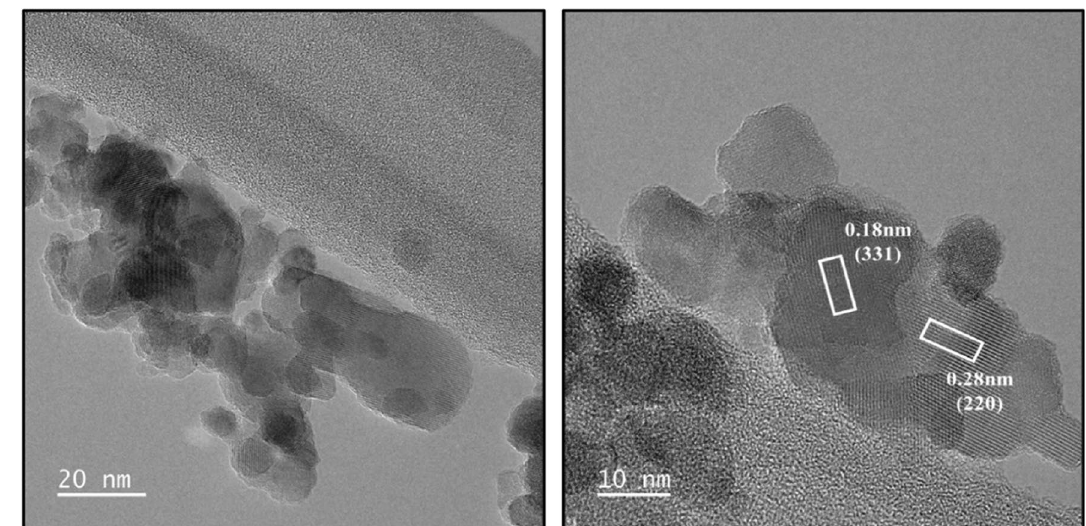
Figure 3. TEM (left) and HR-TEM (right) micrographs of V x -MnCo (x = 0.3)